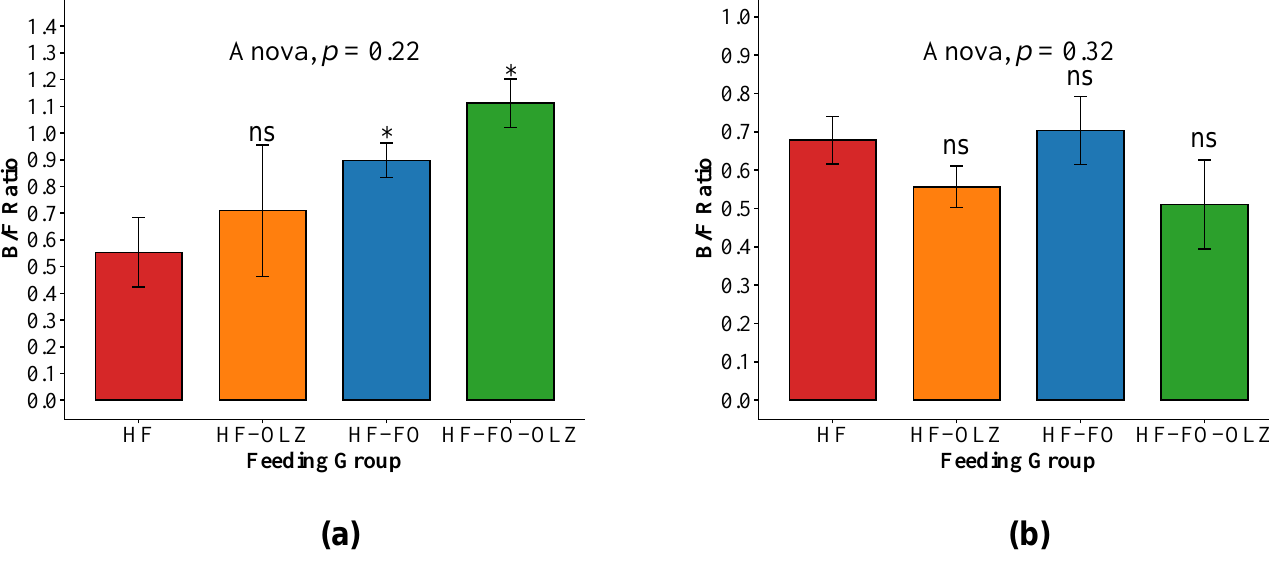
Figure 4. B/F ratio in male ( a ) and female ( b ) mice. Data are shown as mean ± SEM for each group. ANOVA p value for the multiple group comparisons are shown. The pairwise comparison is to compare the HF group versus the other groups, individually (* for p value < 0.05, ns for p >=